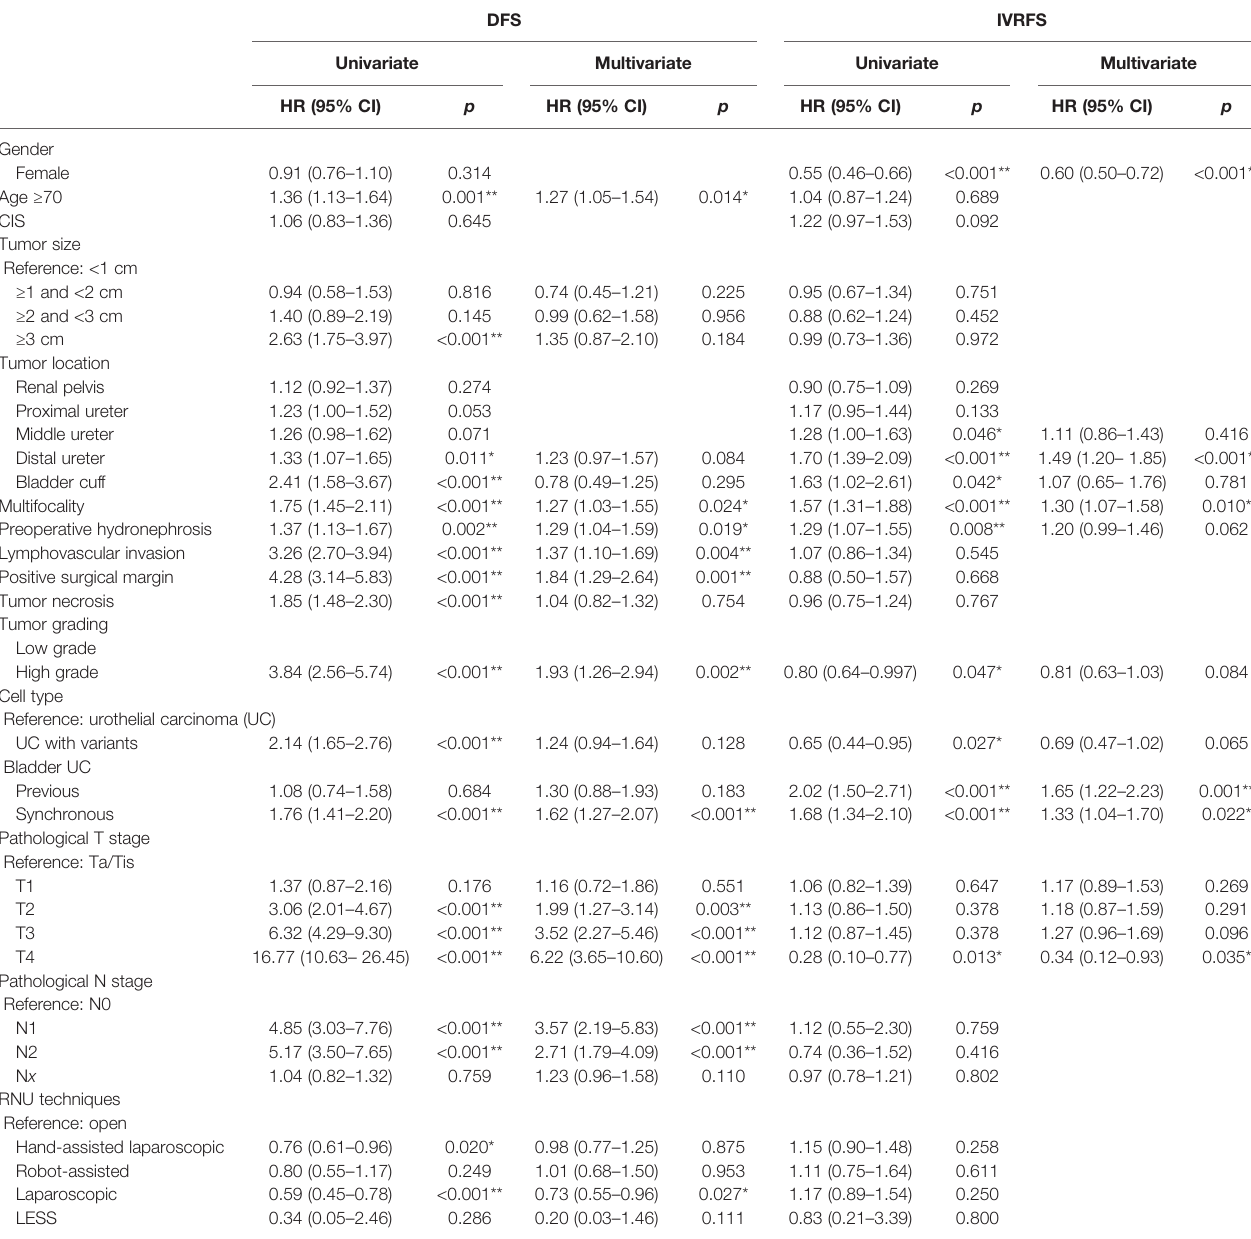
TABLE 3 | Comparative univariate and multivariate analyses of disease-free survival (DFS) and intravesical recurrence-free survival (IVRFS) in patients with